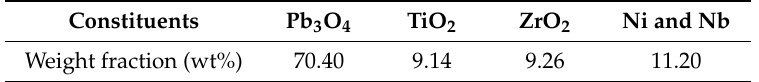
Table 1. The Chemical Composition of The Lead Zirconate Titanate (PZT)